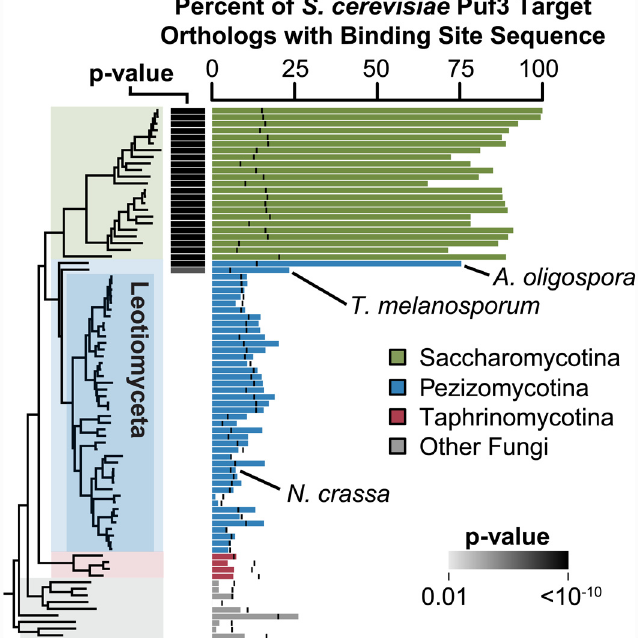
Fig 3. Conservation of S . cerevisiae Puf3 targets in other fungi. The percent of orthologs of S . cerevisiae Puf3 targets (identified by Gerber et al. [25]) that have a match to the Puf3 motif UGUA[ACU]AUA in the 3' UTRs in each species is shown as a bar plot. A black vertical bar marks the background frequency of the Puf3 motif for each species. The 3' UTR was defined as the 500 nucleotides downstream of the stop codon. Only orthologs of S . cerevisiae Puf3 targets that have a Puf3 motif match in 3' UTR were used ( n = 176) so that S . cerevisiae S288C is set at 100%. A significant p -value (gray or black box) indicates that Puf3 motif matches are enriched in orthologs of S . cerevisiae Puf3 targets relative to all other orthologs. p -Values were computed using Fisher's exact test and are Bonferroni corrected for multiple hypothesis testing by multiplication by 80, the number of species tested. The phylogeny represents the evolutionary relationships of the fungi, inferred with a maximum-likelihood approach from a concatenated alignment of 20 protein sequences (Materials and Methods). Species names can be found in S19 Fig Percentages and p -values can be found in S1